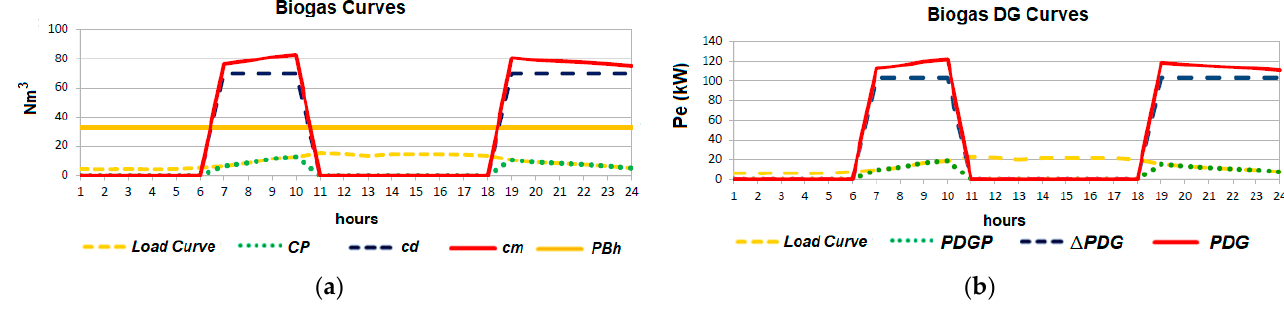
Figure 11. Case 2: ( a ) Biogas curves; ( b ) MOR from biogas DG.